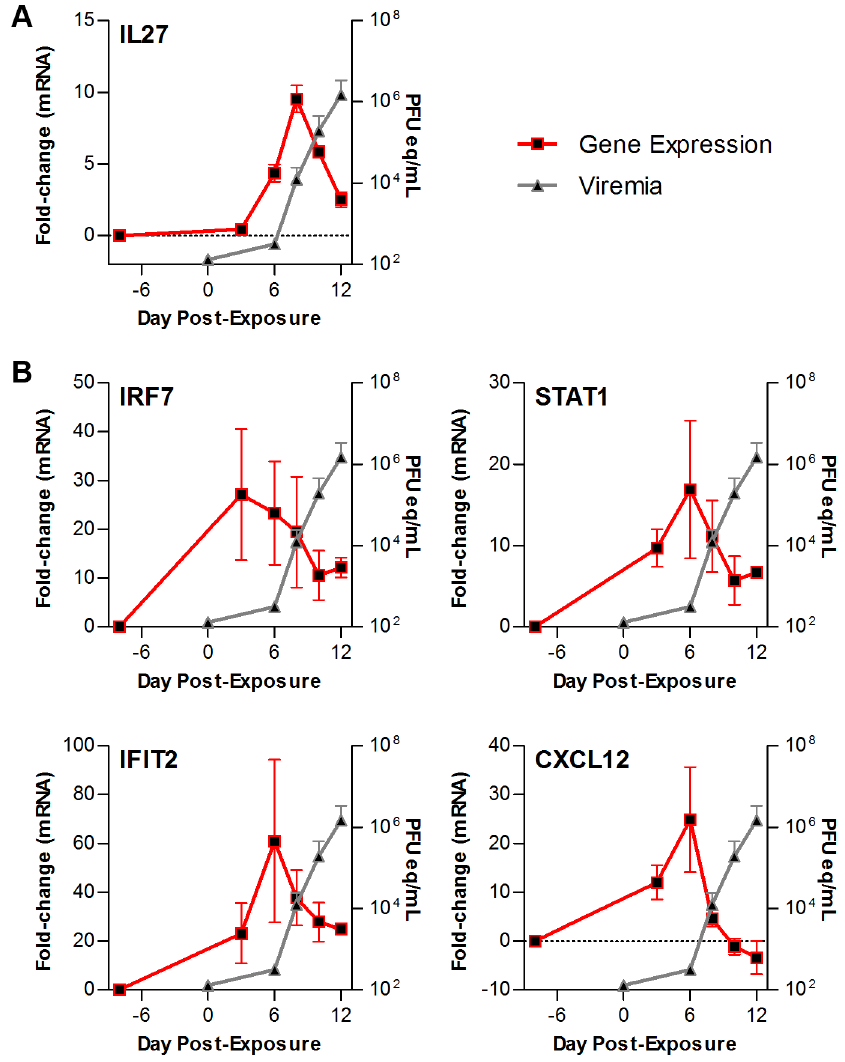
Figure 5. Gene expression precedes the detection of viremia in LASV-exposed NHPs. Comparison of observed mRNA expression level changes over the course of infection (red line) to the appearance of virus in the blood (grey line) in LASV-exposed NHPs. Shown here are probes for (A) the cytokine IL27; and (B) genes involved in the innate antiviral response: IRF7 (top left), STAT1 (top right), IFIT2 (bottom left), and CXCL12 (bottom right). Error bars represent